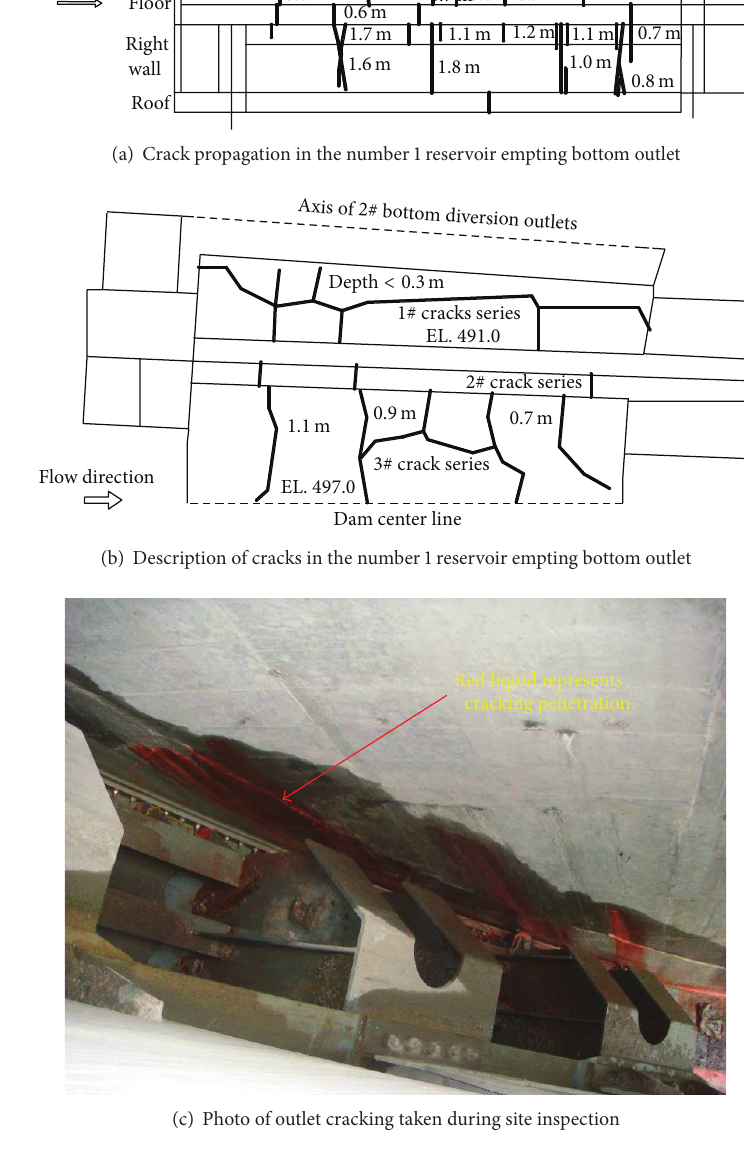
Figure 2: Schematic sketch and photo of outlet cracking in the number 1 reservoir empting bottom outlet of the Goupitan arch dam.